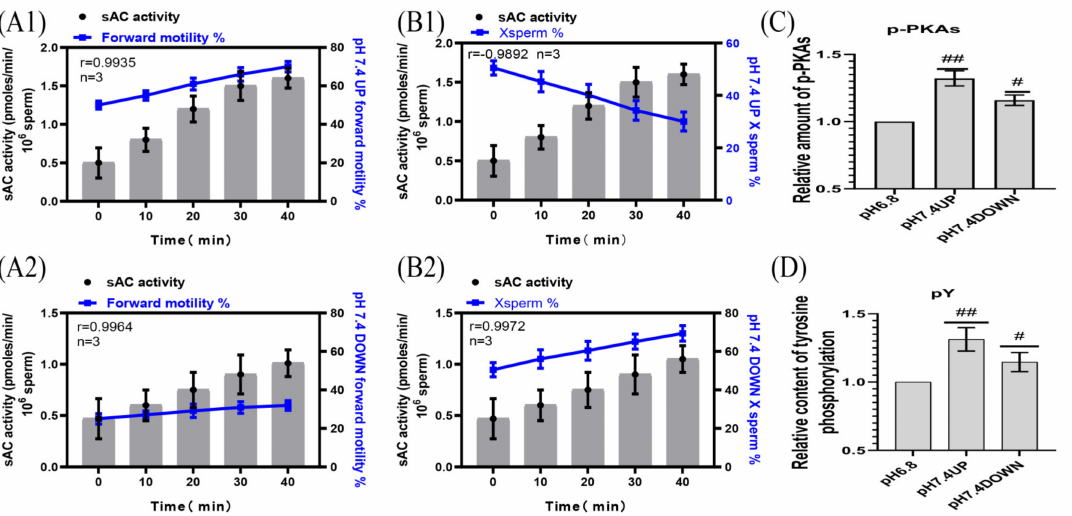
Figure 6. Correlation of sAC protein activity with sperm motility activity. ( A1 , A2 ) sAC protein activity was correlated with the proportion of forwardly motile spermatozoa. ( B1 , B2 ) Correlation between sAC protein activity and the proportion of X-chromosome-bearing sperm. ( C , D ) Statistics of the relative contents of p-PKAs and pY in dilutions of pH6.8 and pH7.4. Results are expressed as mean ± SEM, n = 3 experiments. Two-way ANOVA and Bonferroni’s multiple comparison test. (##) and (#) indicate significant differences between the two sets of data, respectively ( p < 0.01) and ( p <